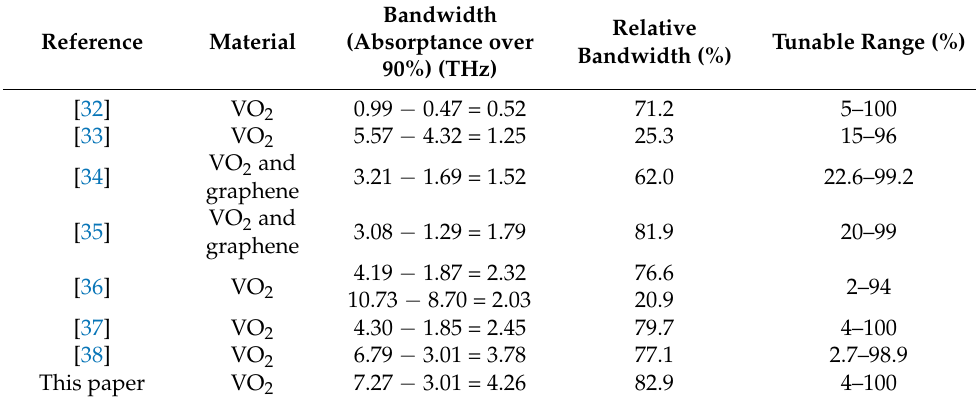
Table 1. Comparison of absorption performance of other absorbers with that of the absorber proposed in this